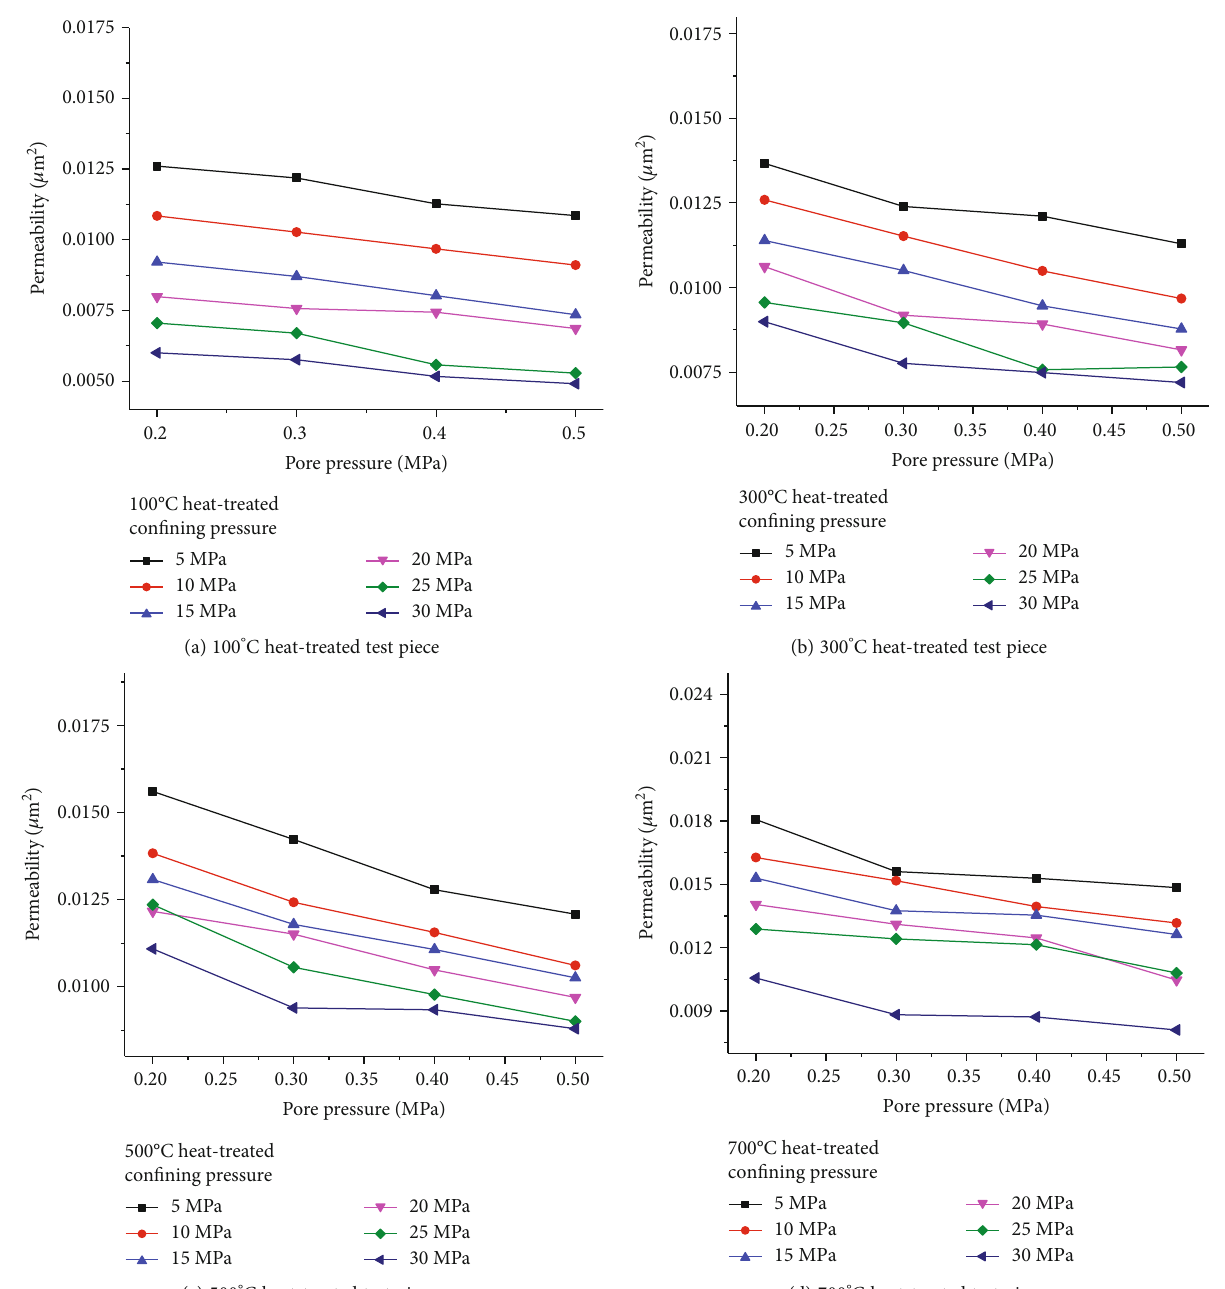
Figure 15: The pore pressure and permeability